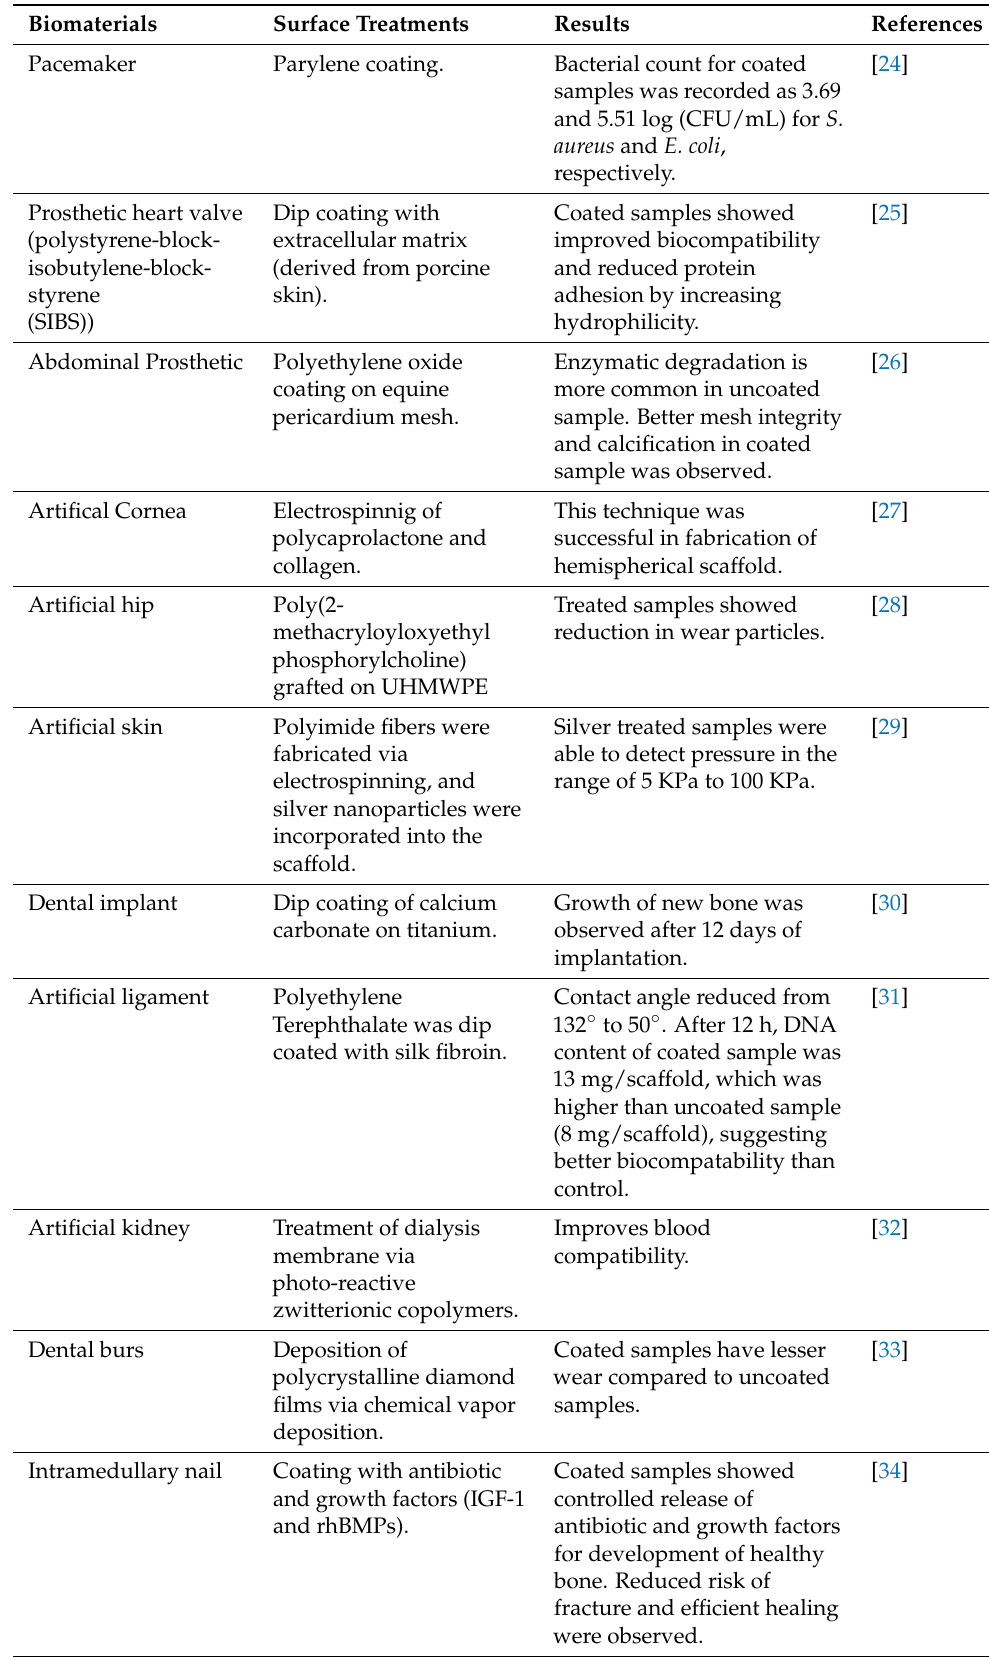
Table 1. Surface treatment of widely used biomaterials to obtain desired functional